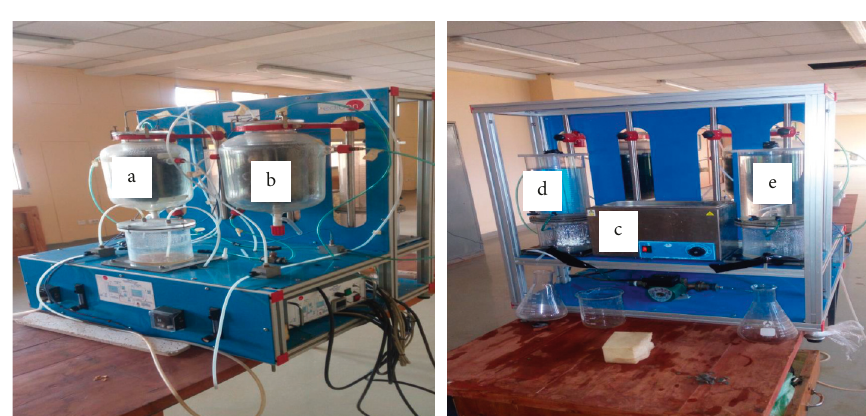
Figure 2: EDBON experimental setup (a and b are digester tanks, d and e are biogas collectors, and c is temperature regulator or water